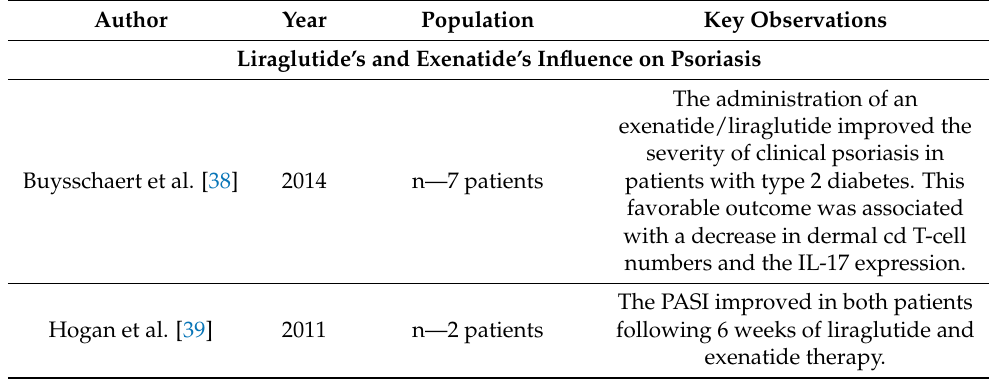
Table 17. Summary of the studies on liraglutide’s and exenatide’s influence on